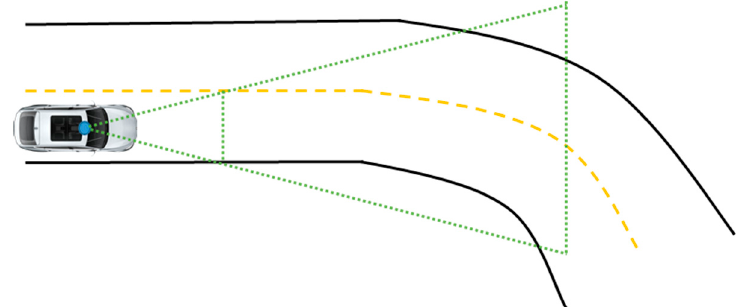
Figure 1. Field of view on the road turning.